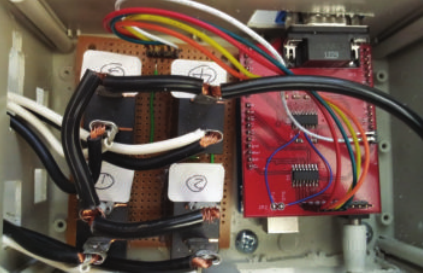
Figure 4: Local controller with controllability over power to